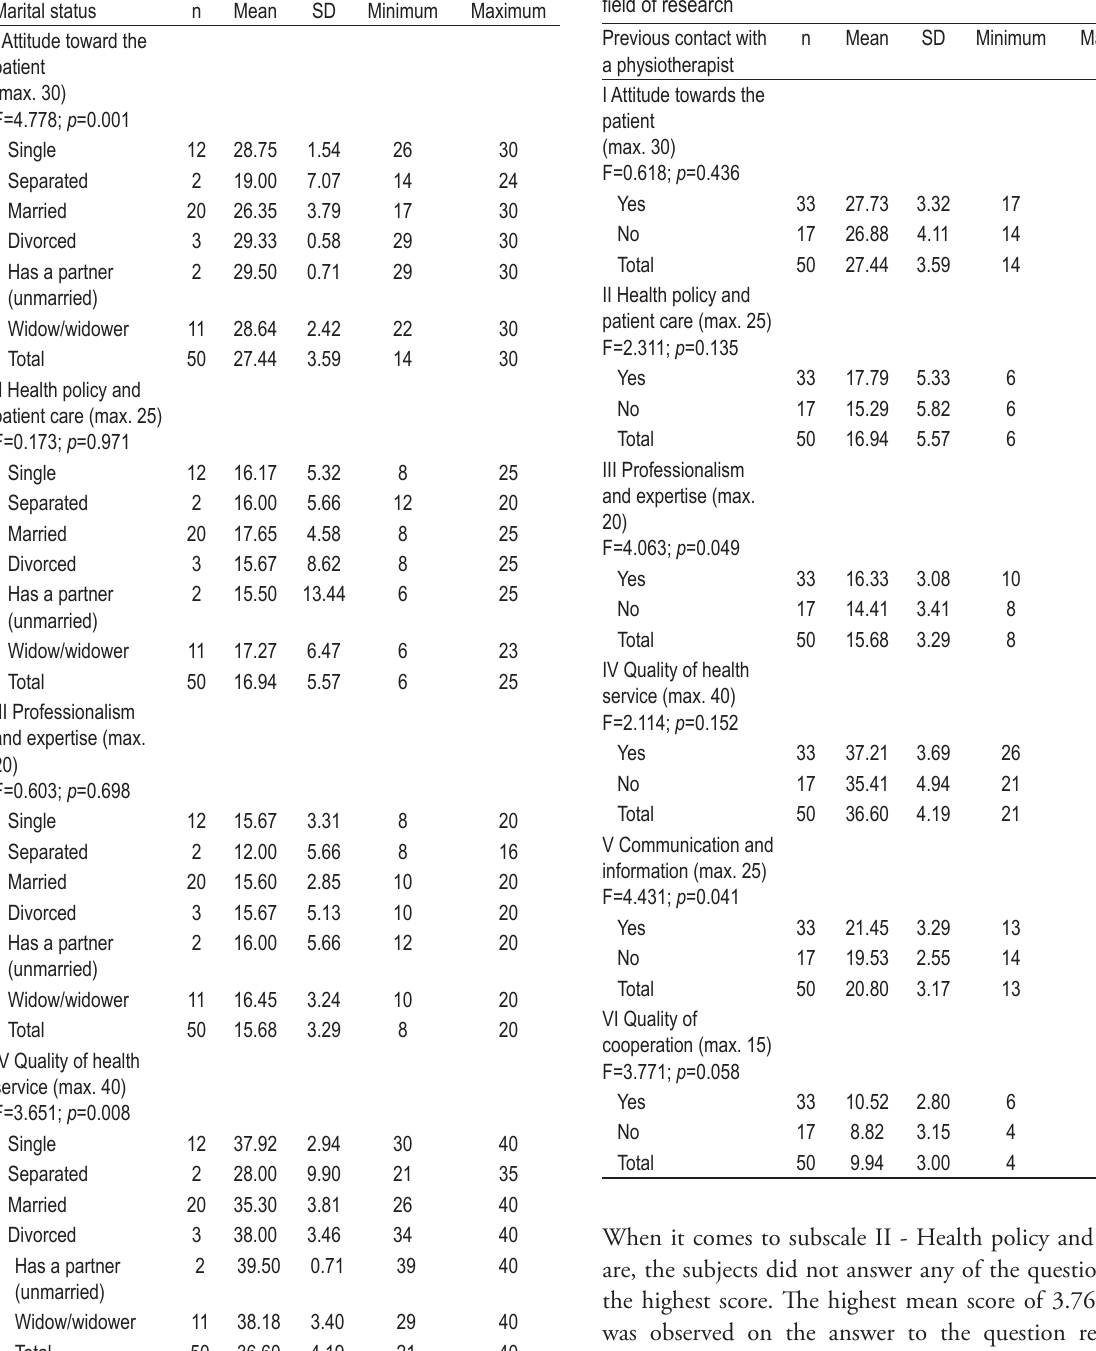
TABLE 9. Effect of marital status on fields of